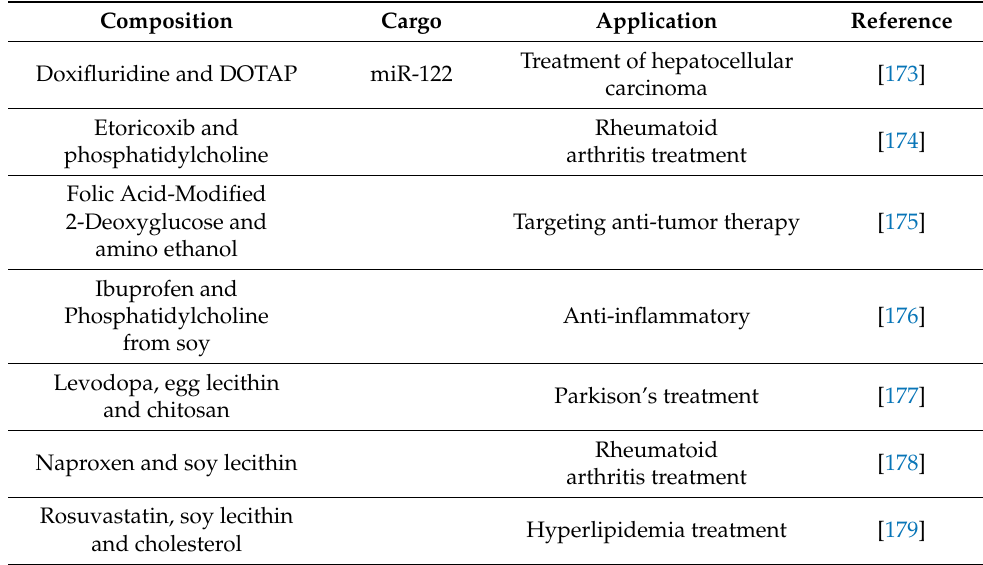
Figure 5. Schematic structure of pharmacosomes lipid vesicular system. Among the few limitations relating to the use of pharmacoses, reference should be made to their susceptibility to hydrolyzation, fusion, or aggregation during storage or engineering processes [171,172]. Table 5. Pharmacosomes’ drug delivery